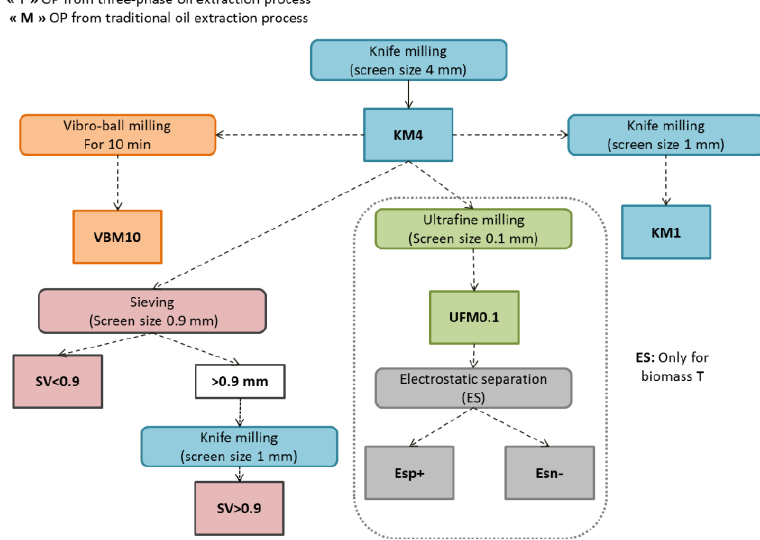
Figure 1. Dry fractionation process of olive pomace biomass developed in this study.